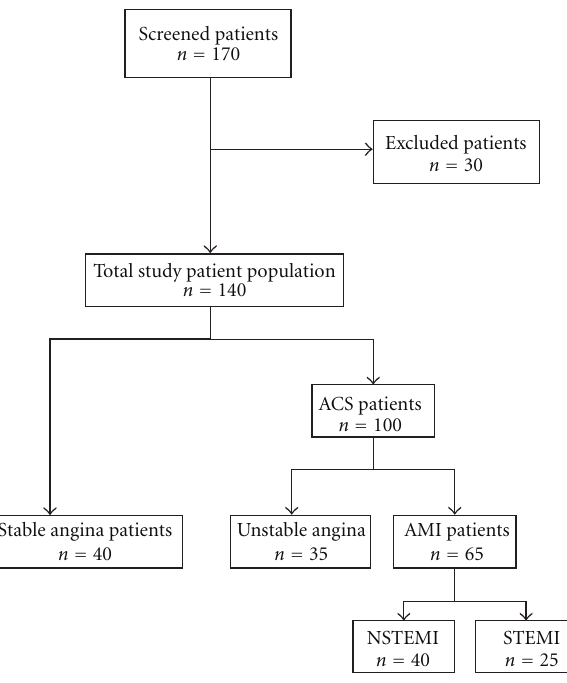
Figure 1: Flow diagram of subject recruitment. Ten patients were excluded for the following reasons: malignant diseases ( n = 1), active infections ( n = 3), and end stage renal disease ( n = 3) recent surgery ( n = 3). Also 20 patients with negative coronary angiography were